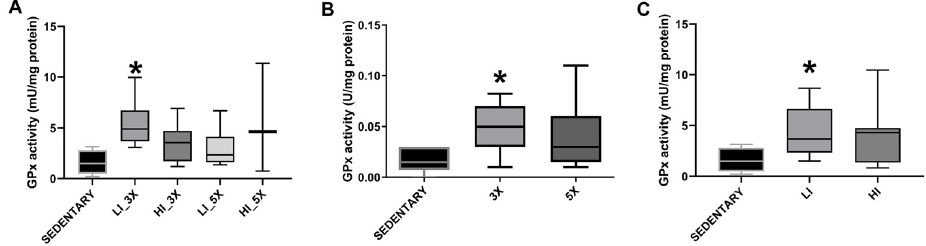
Figure 6. Median and interquartile range of glutathione peroxidase (GPx) activity in renal tissue samples from groups (sedentary, trained at low [LI] and high [HI] intensity, three times [3X] and fi ve times [5X] per week) ( A ) and according to animals grouped by training frequency (three and fi ve times per week) ( B ) and training intensity (low and high intensity) ( C ). *P o 0.05 compared with sedentary group